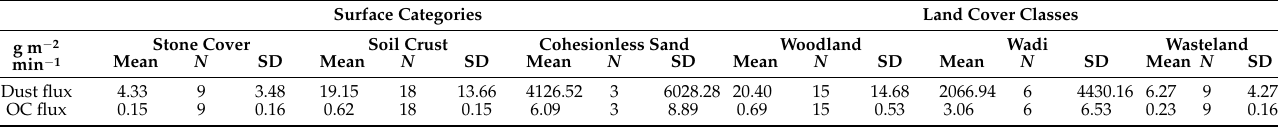
Table 4. Mean horizontal dust flux and organic carbon flux for surface and LCC categories.